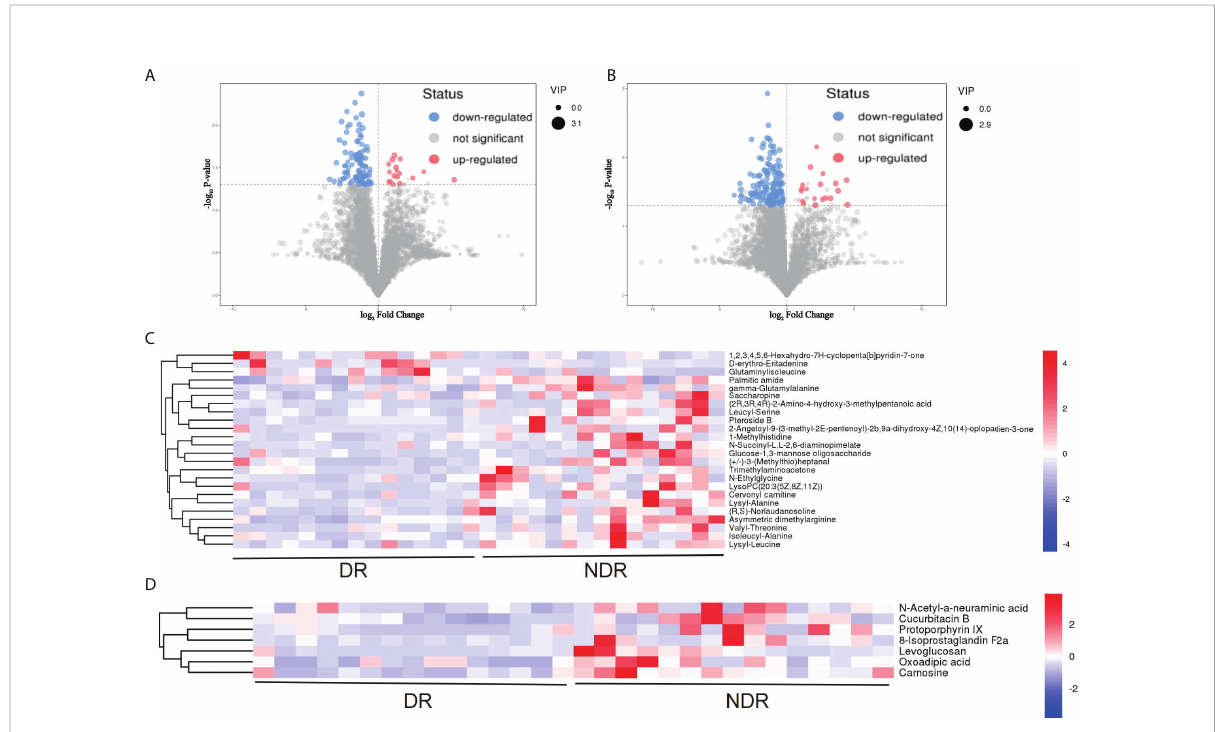
FIGURE 4 DE metabolites between DR and NDR. (A) Volcano plot indicating upregulated and downregulated metabolites using the positive ion model. (B) Volcano plot indicating upregulated and downregulated metabolites using the negative ion model. (C) Heat map of DE metabolites using the positive ion model. (D) Heat map of DE metabolites using the negative ion model. DE, differentially